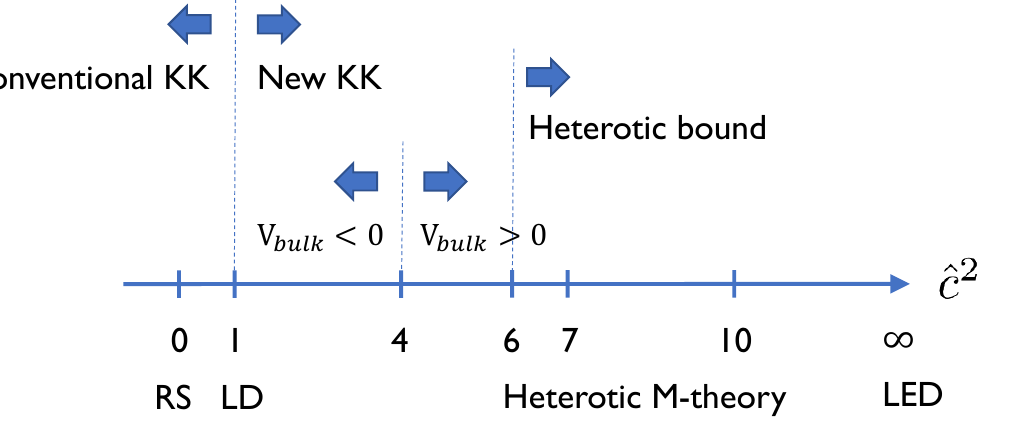
Figure 3 . Critical points of ^ c 2 . Heterotic M-theory can realize the GLD clockworks with ^ c 2 (cid:21)